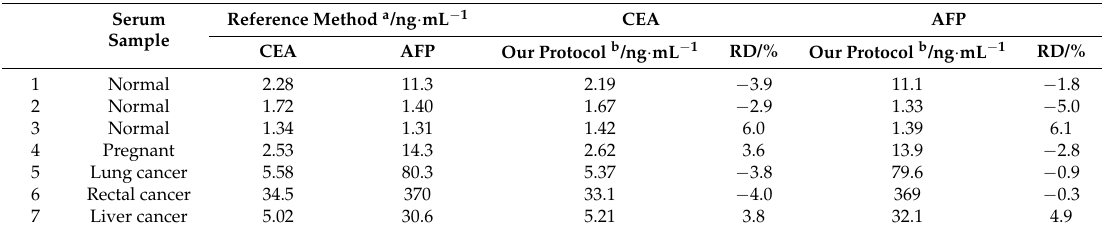
Table 3. Immunoassays of CEA and AFP in clinical serum samples by our protocol and the reference method. Serum